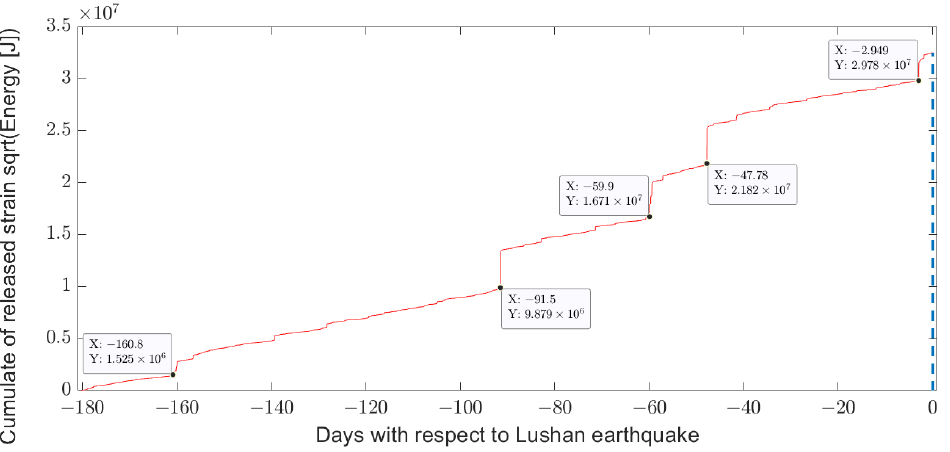
Figure 7. Cumulative Benioff strain S calculated from the earthquake catalog six months before the Lushan earthquake. Only the events equal to or greater than the completeness magnitude of 0.6 were considered in the graph.